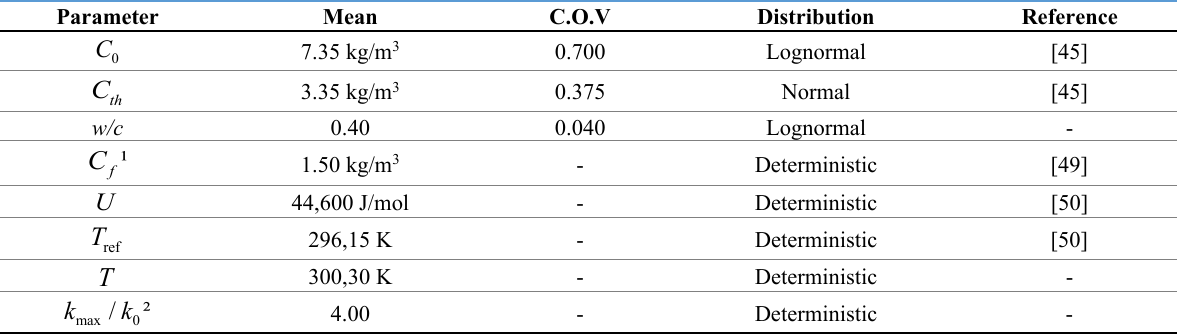
Table 1. Model input parameters.